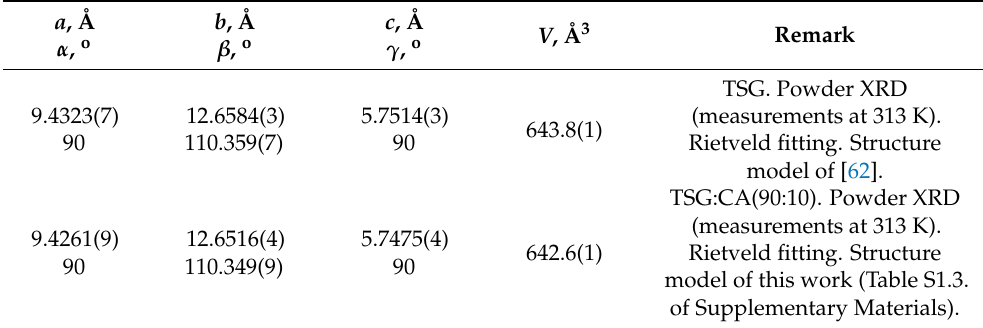
Figure 4. Rietveld fit results for ( a ) TGS and ( b ) TGS:CA (90:10). The Miller indices hkl of some selected non-overlapping reflections are indicated. Insets in ( a , b ) show the high angle regions of the XRD patterns. Table 4. TGS (space group P 2 1 (4)) and TSG:CA(90:10) unit cell parameters obtained in this work by Rietveld fitting of calculated diffraction patterns to experimental ones a